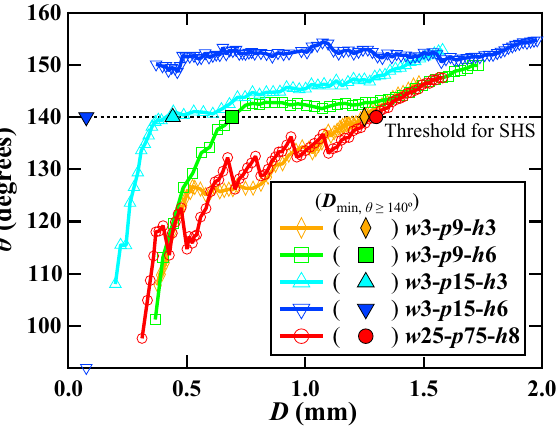
Figure 9. Plot of apparent CA vs. droplet diameter ( θ − D curve) on five different